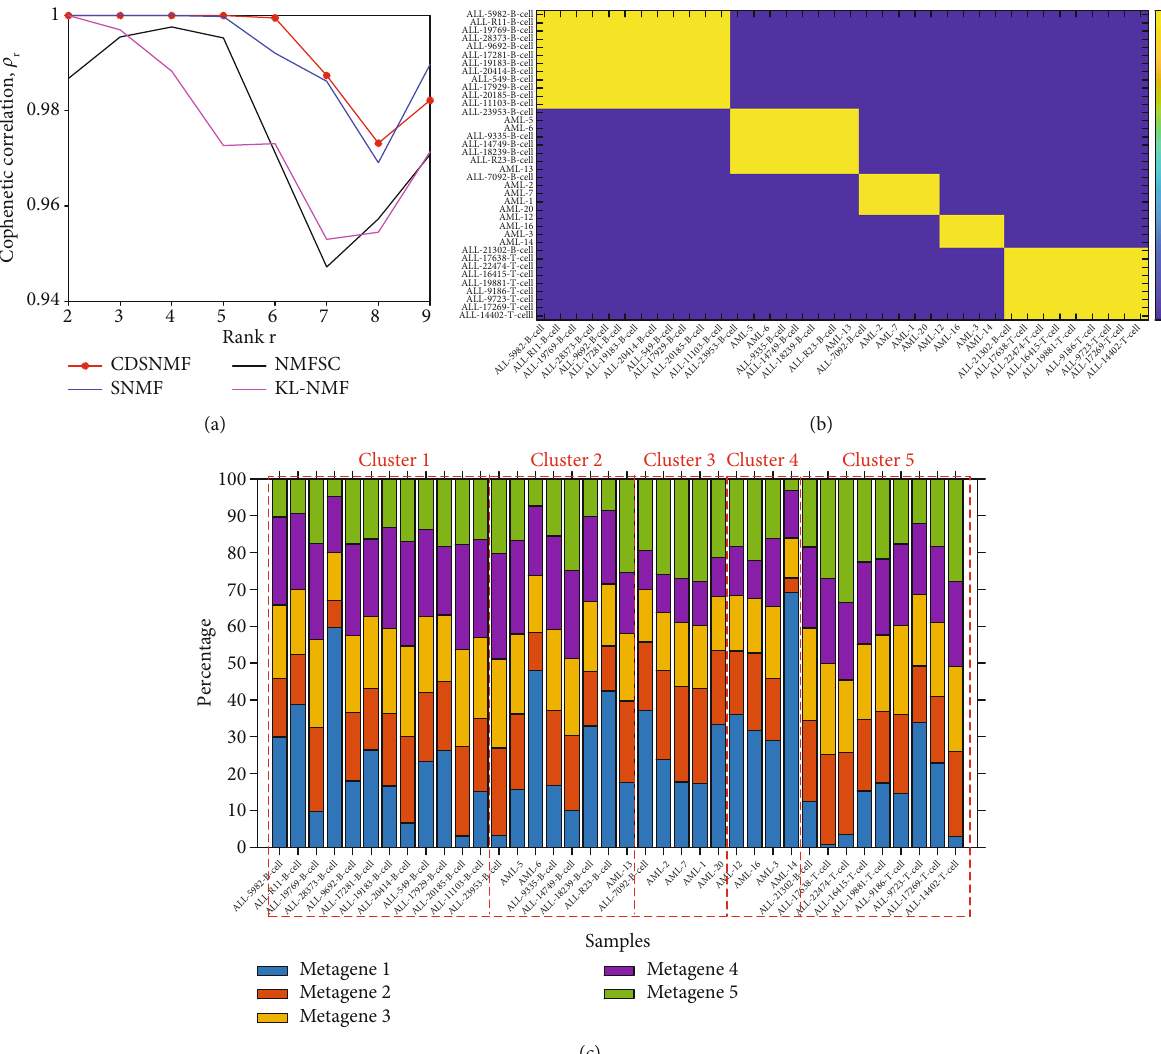
Figure 5: ALL-AML data: (a) cophenetic correlation coe ffi cient by varying r from 2 to 9. (b) Reordered consensus matrix for the optimal rank r = 5 obtained by using the winner algorithm CDSNMF. (c) Stacked bar plots of the encoding matrix V provided by CDSNMF for the optimal rank r = 5